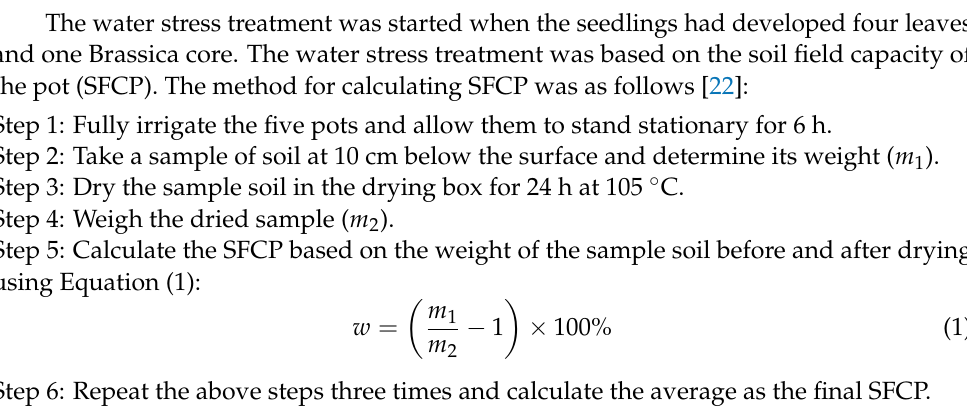
Figure 2. Seedlings of Chinese Brassica with independent irrigation pipes.